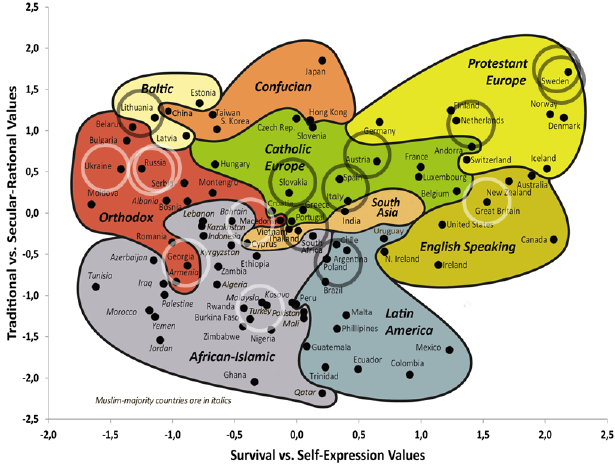
Fig. 3 . Location of the 16 case study “hotspot” landscapes in EU (darker circles) and non-EU (lighter circles) countries on the WVS wave 6 (2010–2014) Inglehart–Welzel Cultural Map (http://www.worldvaluessurvey.org/images/ Culture_Map_2017_conclusive.png), which shows two major dimensions of cross cultural variation in the world. From left to right these are survival values versus self-expression values, and bottom-up from traditional values versus secular-rational values.